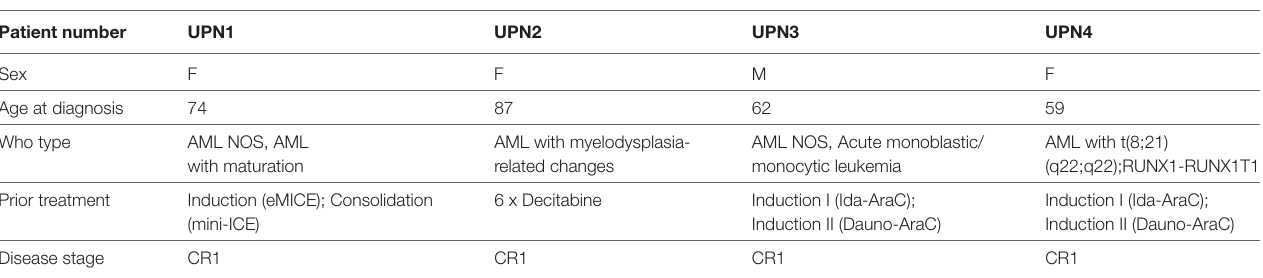
TaBle 1 | Patient